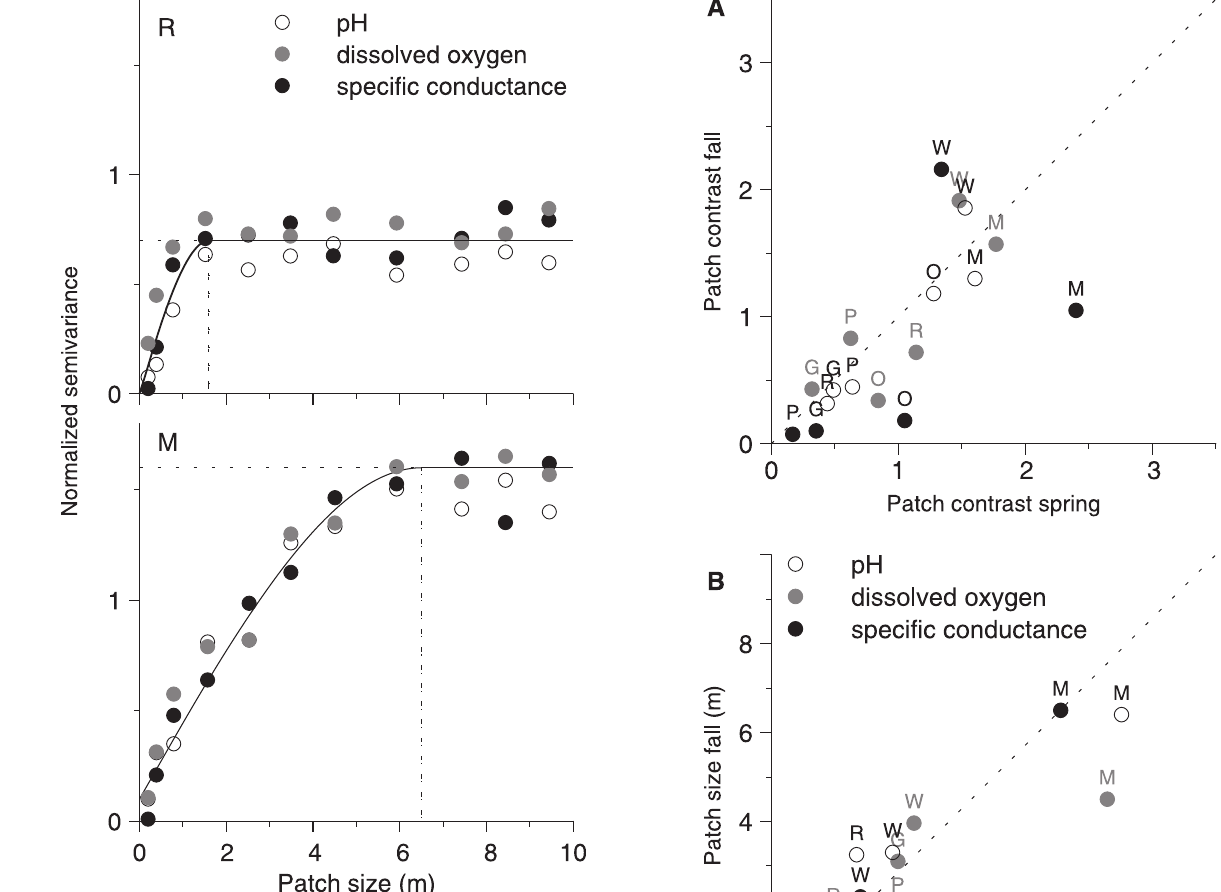
Figure 3. Geostatistical analysis: variograms of contrasting stream reaches. Normalized semivariances of the hyporheic param- eters specific conductance, dissolved oxygen and pH as a function of distance between sampling sites for two contrasting stream reaches (R and M). A spherical variogram model (solid line is only for illustration; for analysis, models were fitted individually for each parameter) quantifies the geostatistical parameters sill (here denoted patch contrast and representing the maximum value, horizontal dashed line) and range (here denoted patch size and representing the distance at which the patch contrast is reached, vertical dashed line). Markers show the mean of both sampling dates from the development data set. R=Suedliche Regnitz, M = Moosach.